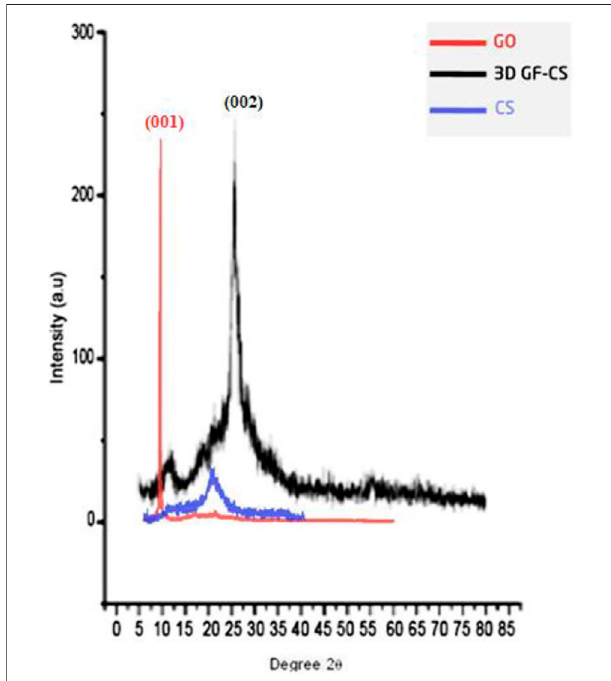
FIGURE 7 | XRD of CS, GO, and 3D GF-CS.